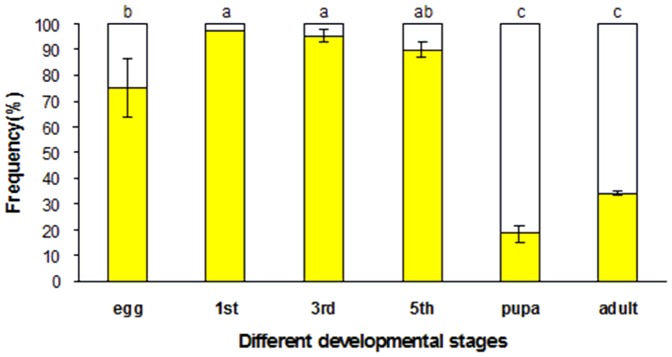
The usage frequencies of OfRyR alternative exons (a and b) in different developmental stages of O. furnacalis.Mutually exclusive exons were represented by yellow bars (exon a) and open bars (exon b). 1st, 3rd and 5th denotes first-instar, third-instar and fifth-instar larva. Different letters above each bar indicate statistical difference by ANOVA followed by the Duncan's Multiple Comparison test (P<0.05).